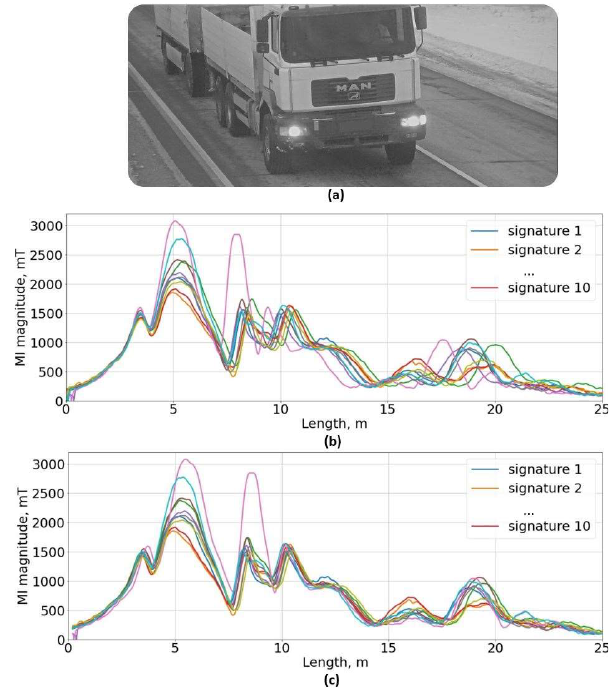
Figure 2. Multiple 18-m truck ( a ) magnetic induction (MI) magnitudes (each color represents unique detection) versus length. ( b ) signatures length estimated according to the speed value from the cross-correlation algorithm, ( c ) corrected signature length by adjusting speed